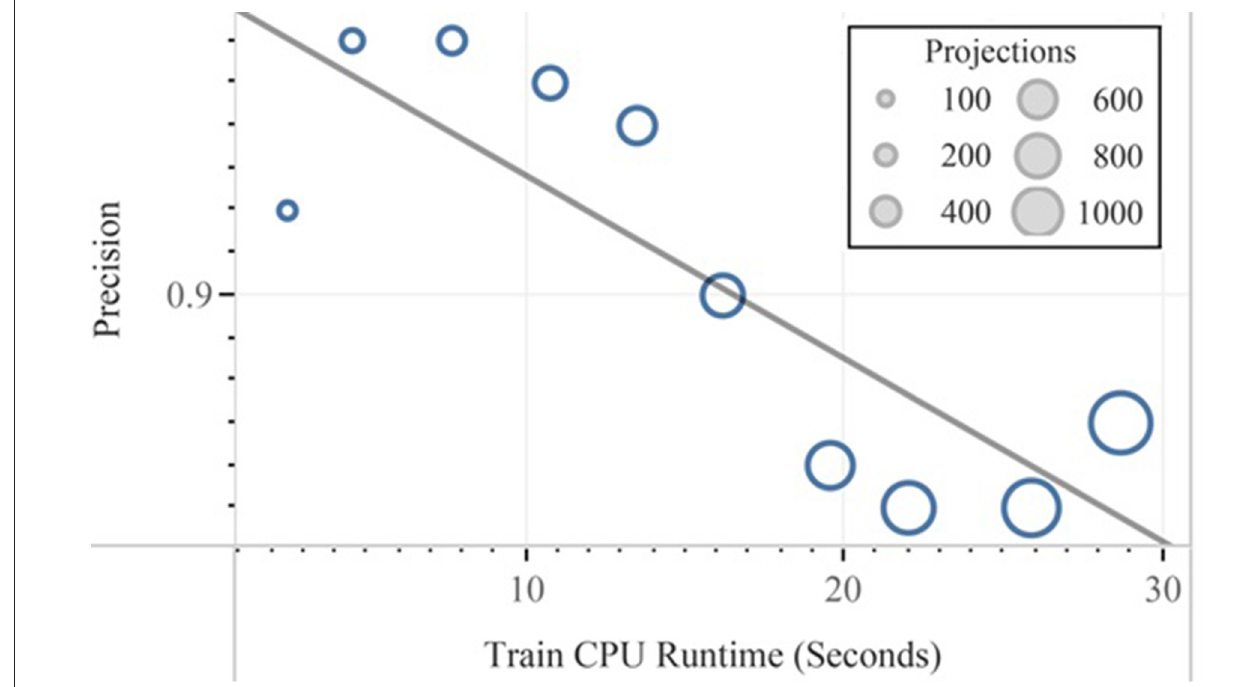
FIGURE 11 | Precision vs. training CPU runtime experimented in QDA.